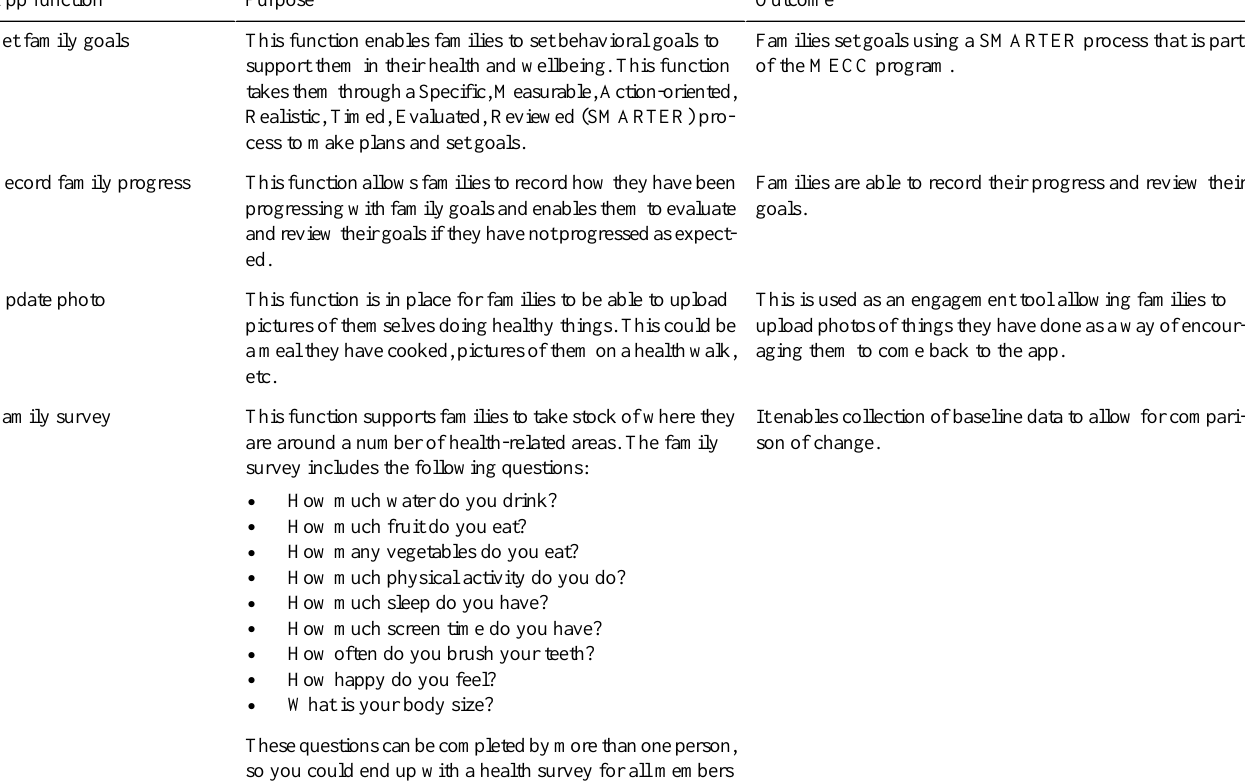
Table 2. NoObesity Family app functional overview. OutcomePurposeApp function